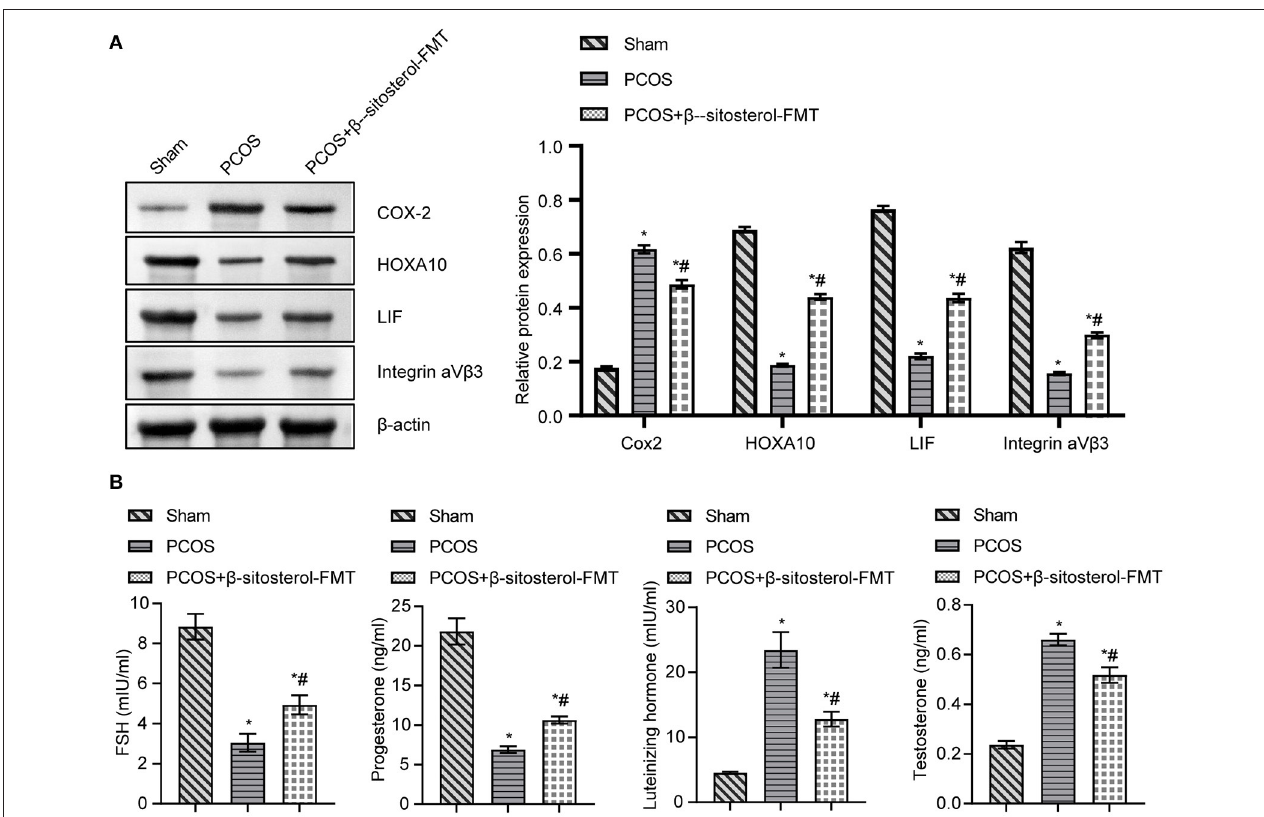
FIGURE 8 | Effect of β -sitosterol-FMT on the expressions of endometrium receptivity markers and related hormones in mice with PCOS. (A) Expressions of COX-2, HOXA10, LIF, and Integrin ανβ 3 in the endometrium of mice in each group were detected by western blot. (B) Levels of FSH, P, LH, and T in the serum of mice in each group were detected by ELISA. Data are presented as mean ± SEM. * P < 0.05 vs. Sham. # P < 0.05 vs. PCOS. PCOS, polycystic ovary syndrome; COX-2, cyclooxygenase-2; HOXA10, homeobox A10; LIF, leukemia inhibitory factor; ELISA, enzyme-linked immunosorbent